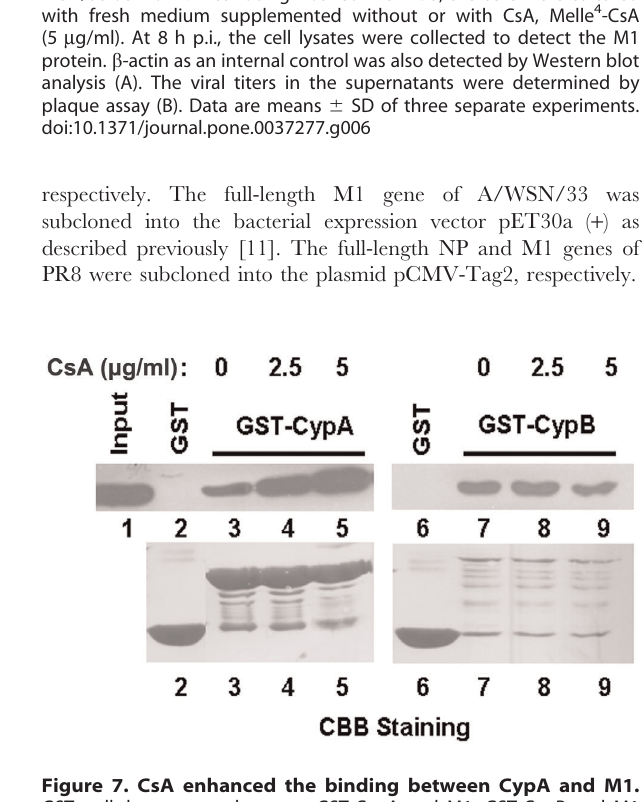
Figure 7. CsA enhanced the binding between CypA and M1. GST pull-down assays between GST-CypA and M1, GST-CypB and M1 were performed in the absence (lane 3, lane 7) or presence (lanes 4, 5, 8, 9) of CsA. The concentrations of CsA in lanes 4, 5, 8, 9 are 2.5, 5, 2.5, 5 m g/ml, respectively. Coomasie brilliant blue (CBB) staining patterns for the pulled-down proteins are shown in the bottom panel.